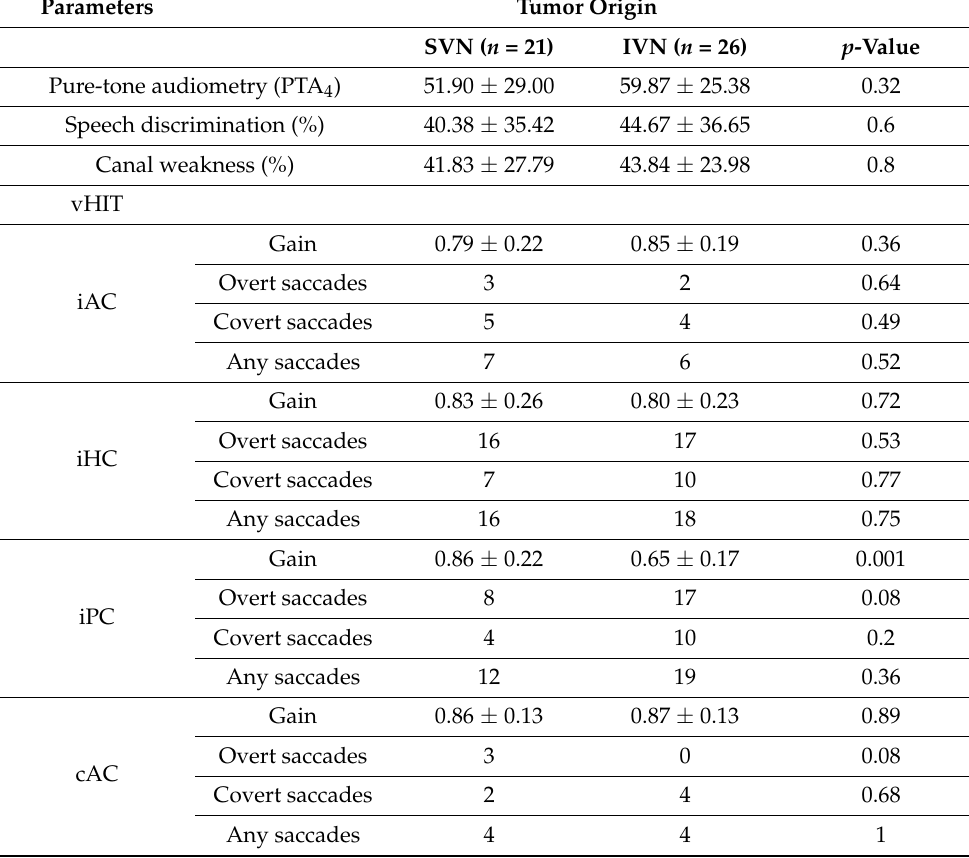
Figure 1. The VOR gain of the ipsilesional (i) and contralesional (c) sides of three semicircular canals in patients with vestibular schwannomas. Compared with the SVN groups, the VOR gain for the IVN groups was reduced significantly only in the iPC; ** p -value < 0.01; SVN, superior vestibular nerve; IVN, Inferior vestibular nerve; AC, anterior canal; HC, horizontal canal; PC, posterior canal; i = ipsilesional; c = contralesional. Table 2. Cochleovestibular function according to tumor origin.